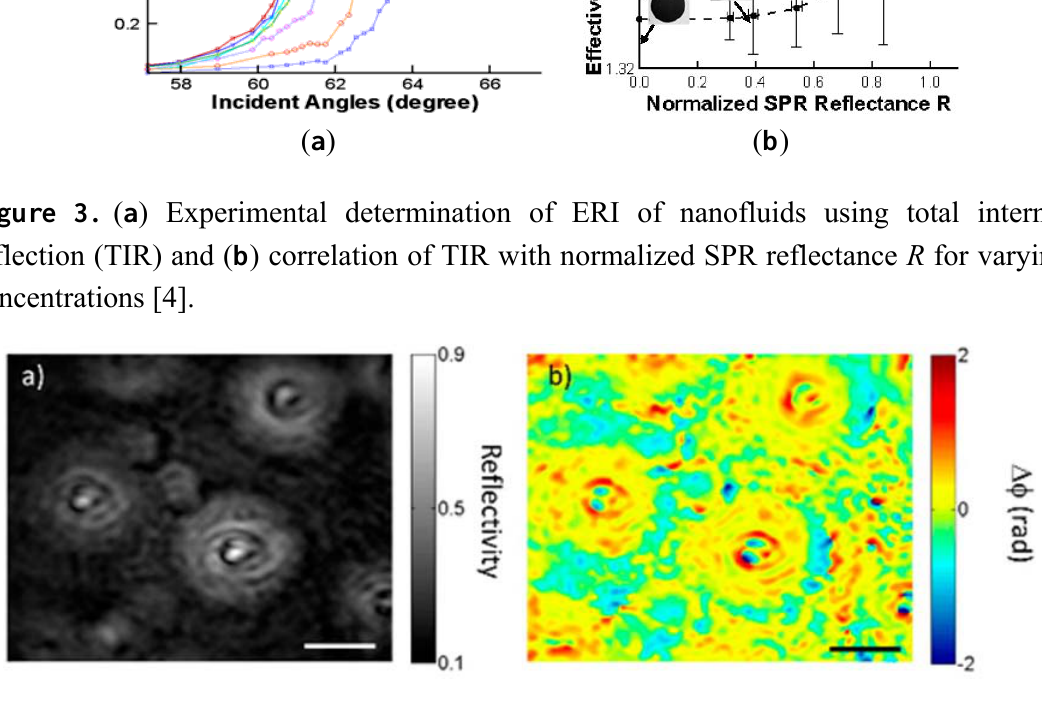
Figure 4. SPR holography shows SPR reflectance image ( a ) and phase contrast image ( b ) for the photoresist dome pattern. Scale bar is 10 μ m. Reprinted with permission from [16]. Copyright 2015 American Chemical